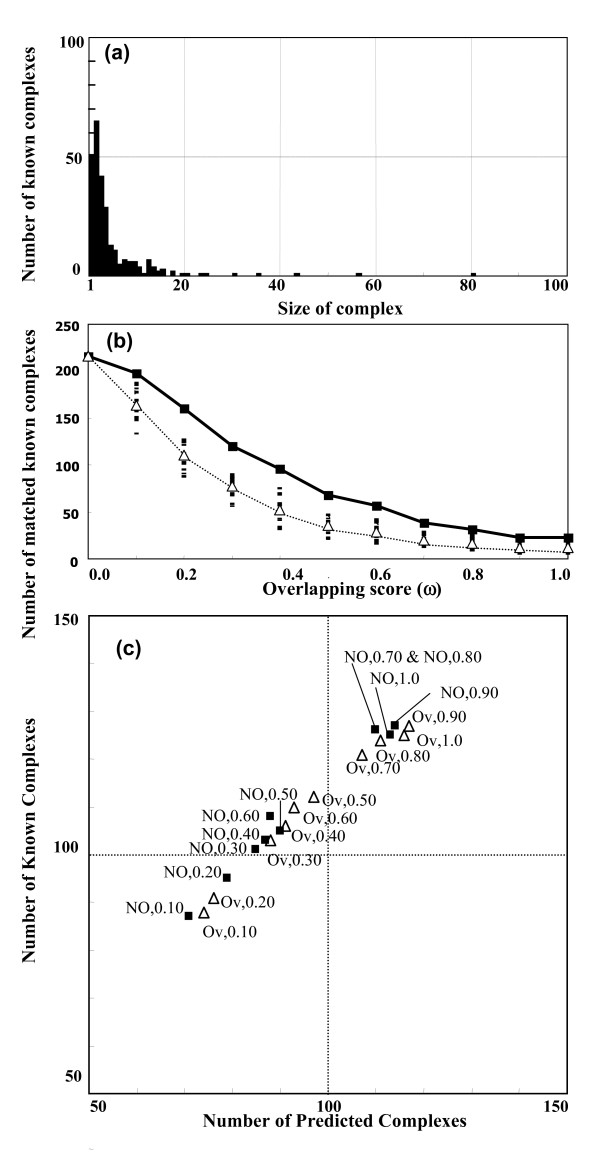
Comparison of predicted complexes with known complexes. (a) Distribution of known complexes with respect to size. (b) Number of matched known complexes with respect to the minimum overlapping score for all 20 sets. The triangular dots (connected by dotted line) show the average and the solid square dots (connected by thick solid line) show the union of the matched known complexes. (c) Number of matched known complexes with respect to number of predicted complexes for 20 sets. Each point is labeled by corresponding mode of clustering, i. e. non-overlapping (NO) or overlapping (Ov) and din value.